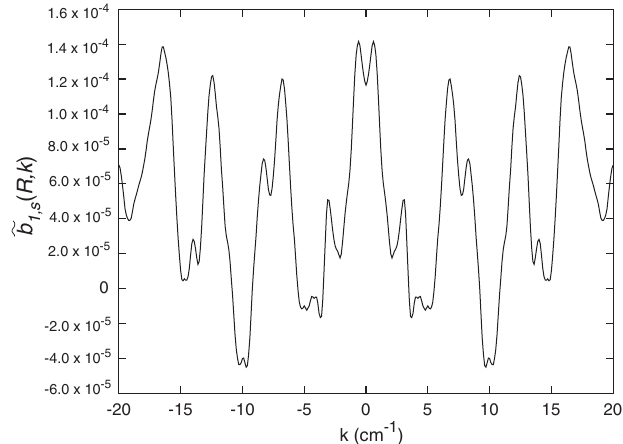
~ ð R; k Þ computed from uniform ran- b 1 ;s